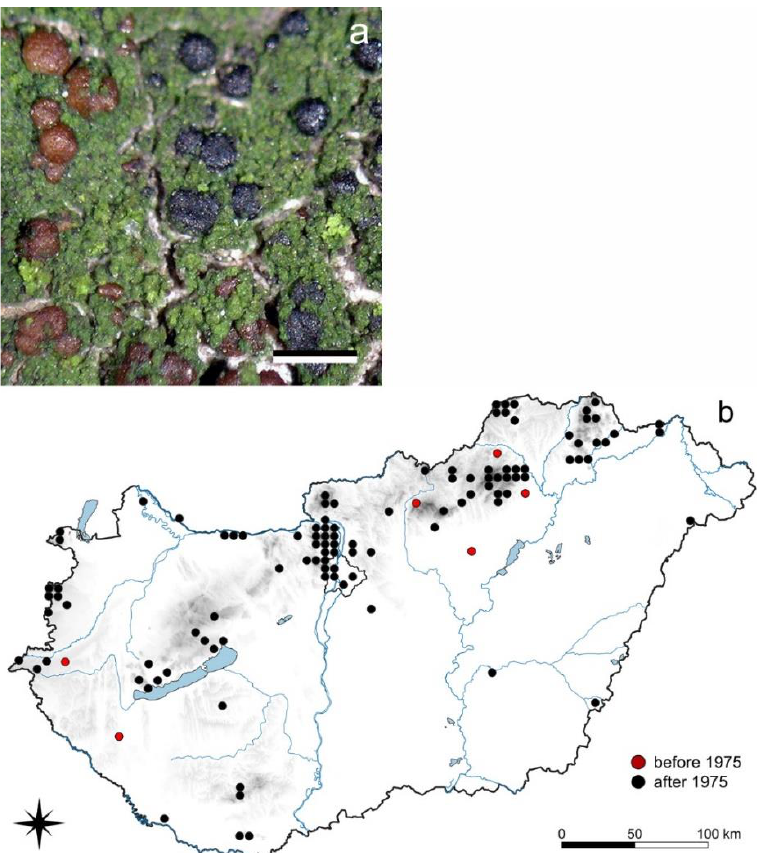
Figure 3. Scoliciosporum chlorococcum ( a ) habit (scale 0.5 mm); ( b ) its distribution in Hungary (322 records altogether). Dots represent c. 5 km × 6 km areas. (Photo: E. Farkas). (322 records altogether). Dots represent c. 5 km × 6 km areas. (Photo: E.